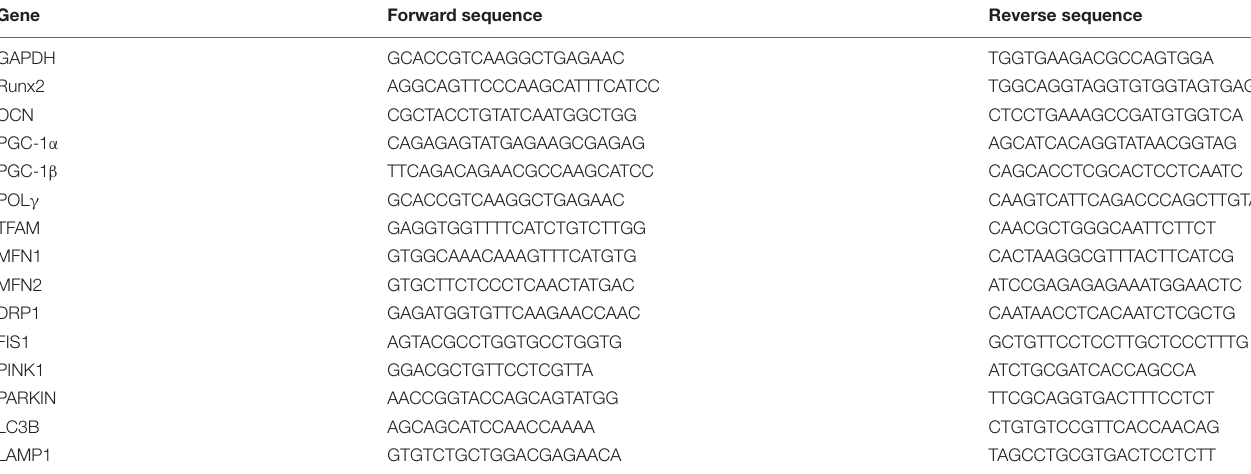
TABLE 1 | Primer sequences used in quantitative real-time PCR. Gene Forward sequence Reverse